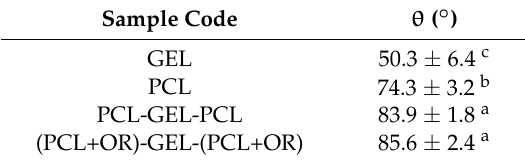
Table 3. Contact angle values of the GEL, PCL, PCL-GEL-PCL, and (PCL+OR)-GEL-(PCL+OR) films.